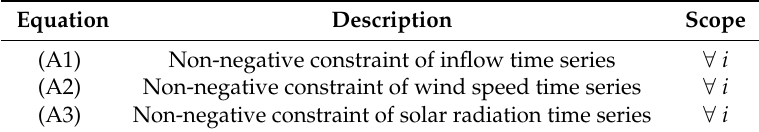
Table A3. Constraints of resources.